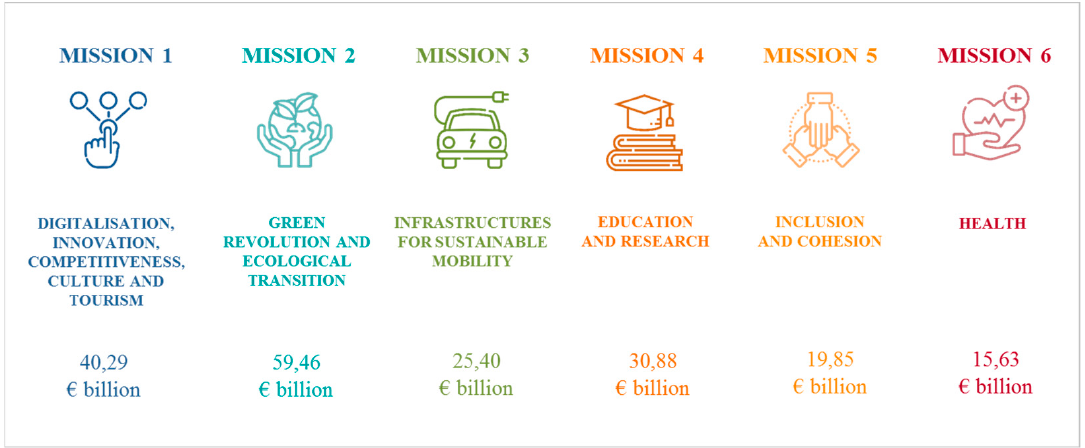
Figure 1. Summary of the NRRP structure.